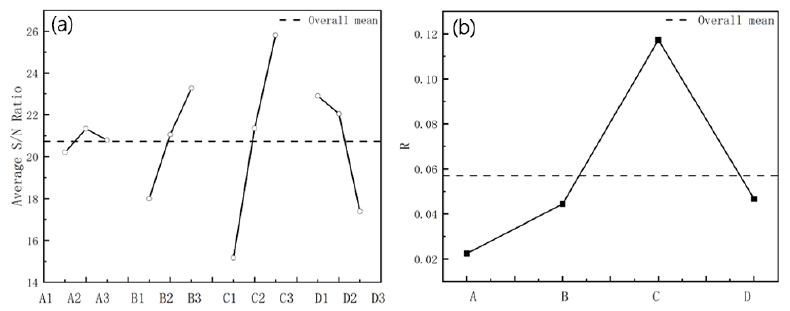
Figure 22. ( a ) The S/N ratio of 4 parameters; ( b ) The value of R with 4 parameters.